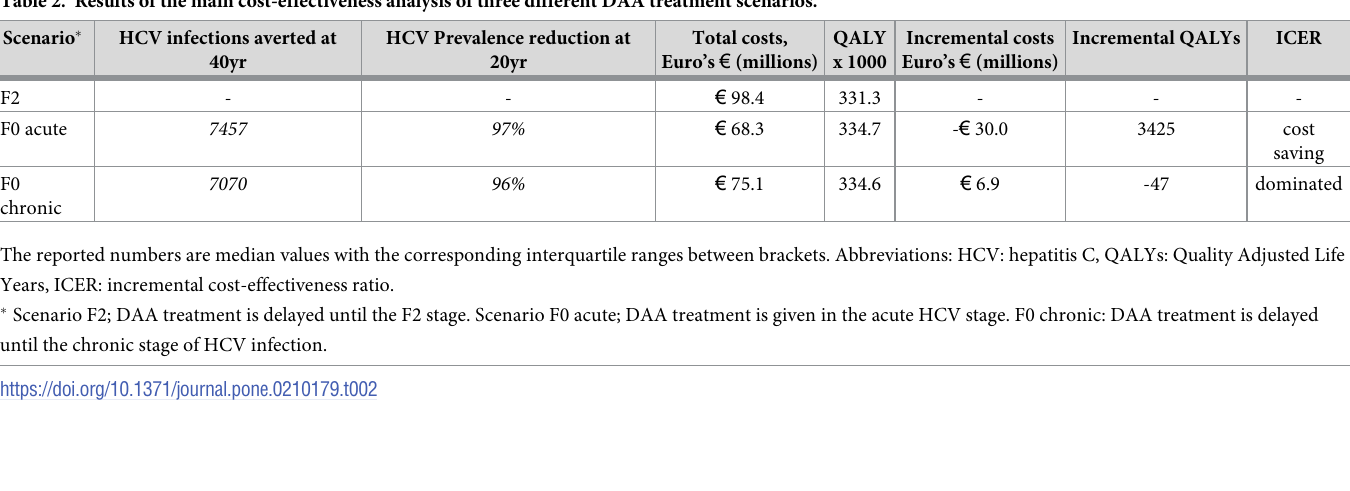
Table 2. Results of the main cost-effectiveness analysis of three different DAA treatment scenarios. Scenario � HCV infections averted at 40yr